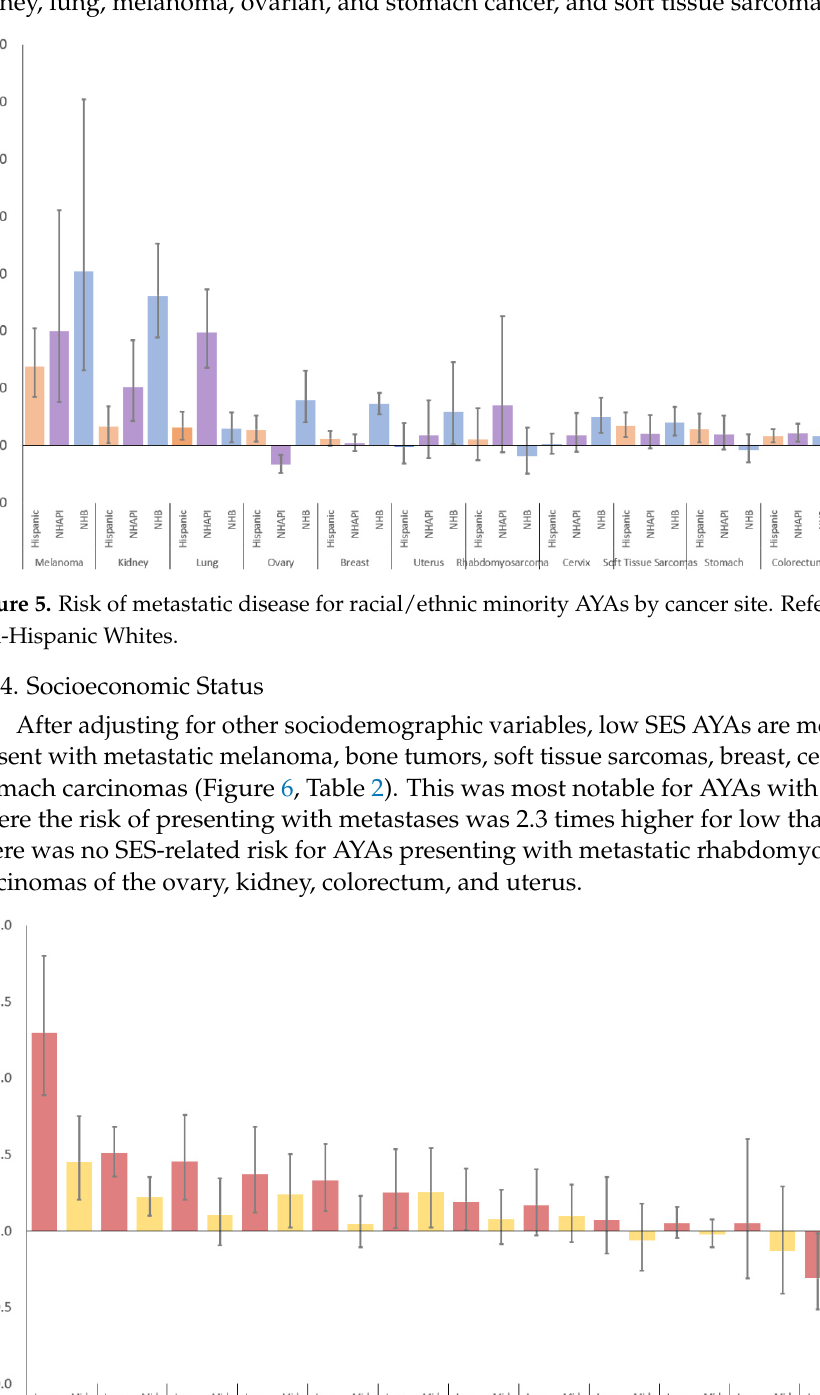
Figure 4. Risk of metastatic disease for male AYAs by cancer site. Reference group: female AYAs.